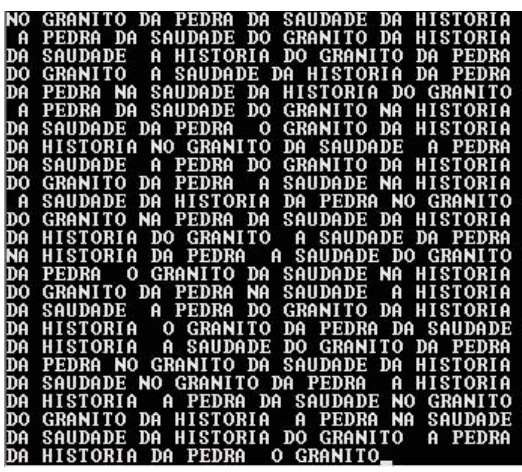
Figure 4. Pedro Barbosa. Porto, 1977.